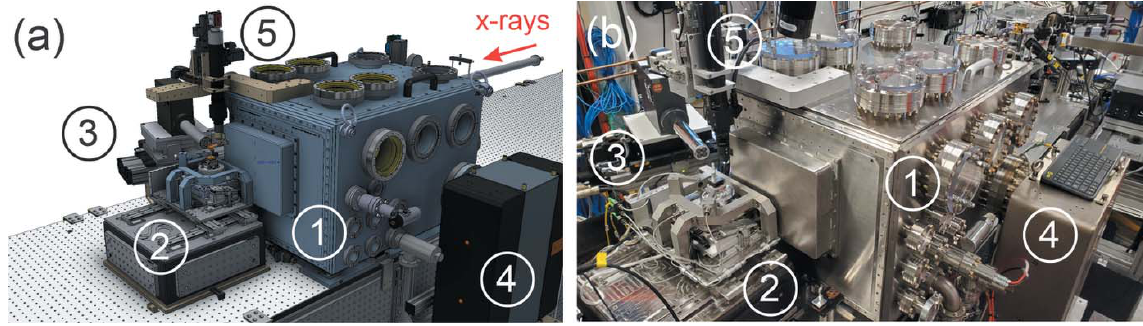
Figure 1 Overview of the KB-based scanning microscope installed at the SRX beamline. The key components are labeled. ( a ) CAD model and ( b ) photograph of